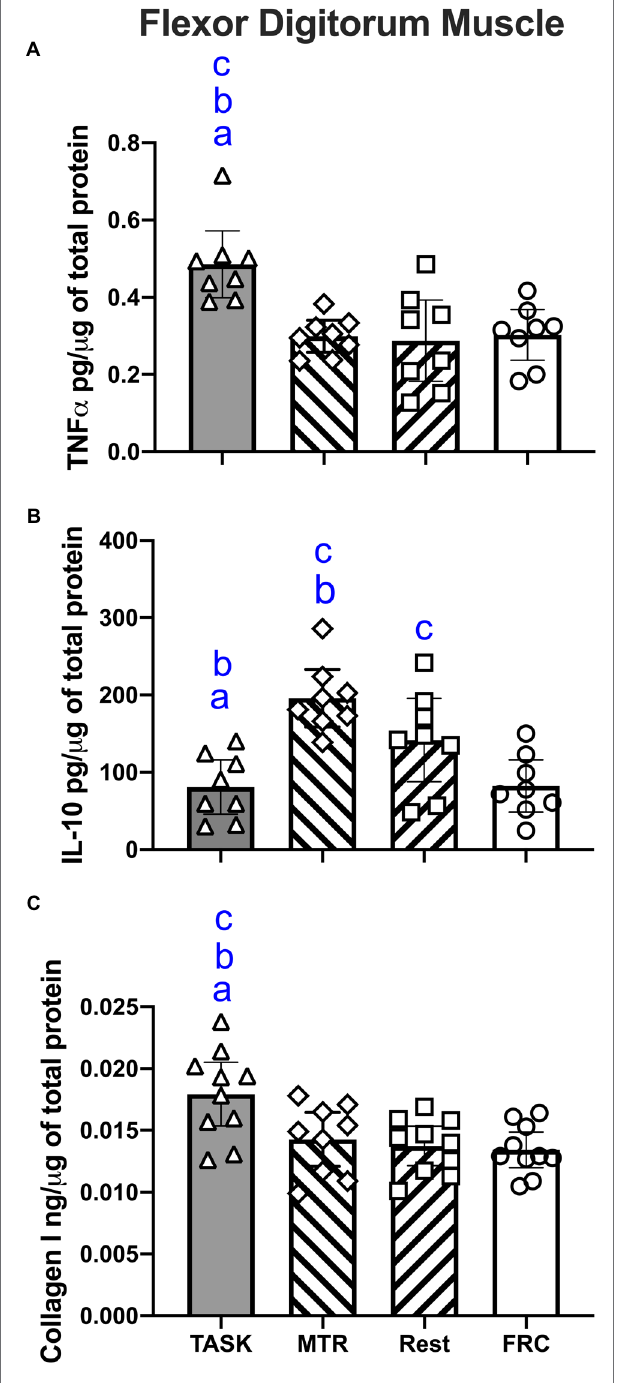
FIGURE 8 | ELISA results for flexor digitorum muscle lysates. (A) TNF α levels. (B) IL-10 levels. (C) Collagen type I levels. Symbols: a , b , and c : p < 0.05 each, compared to MTR, REST, and FRC groups, respectively. Mean ± 95% CI